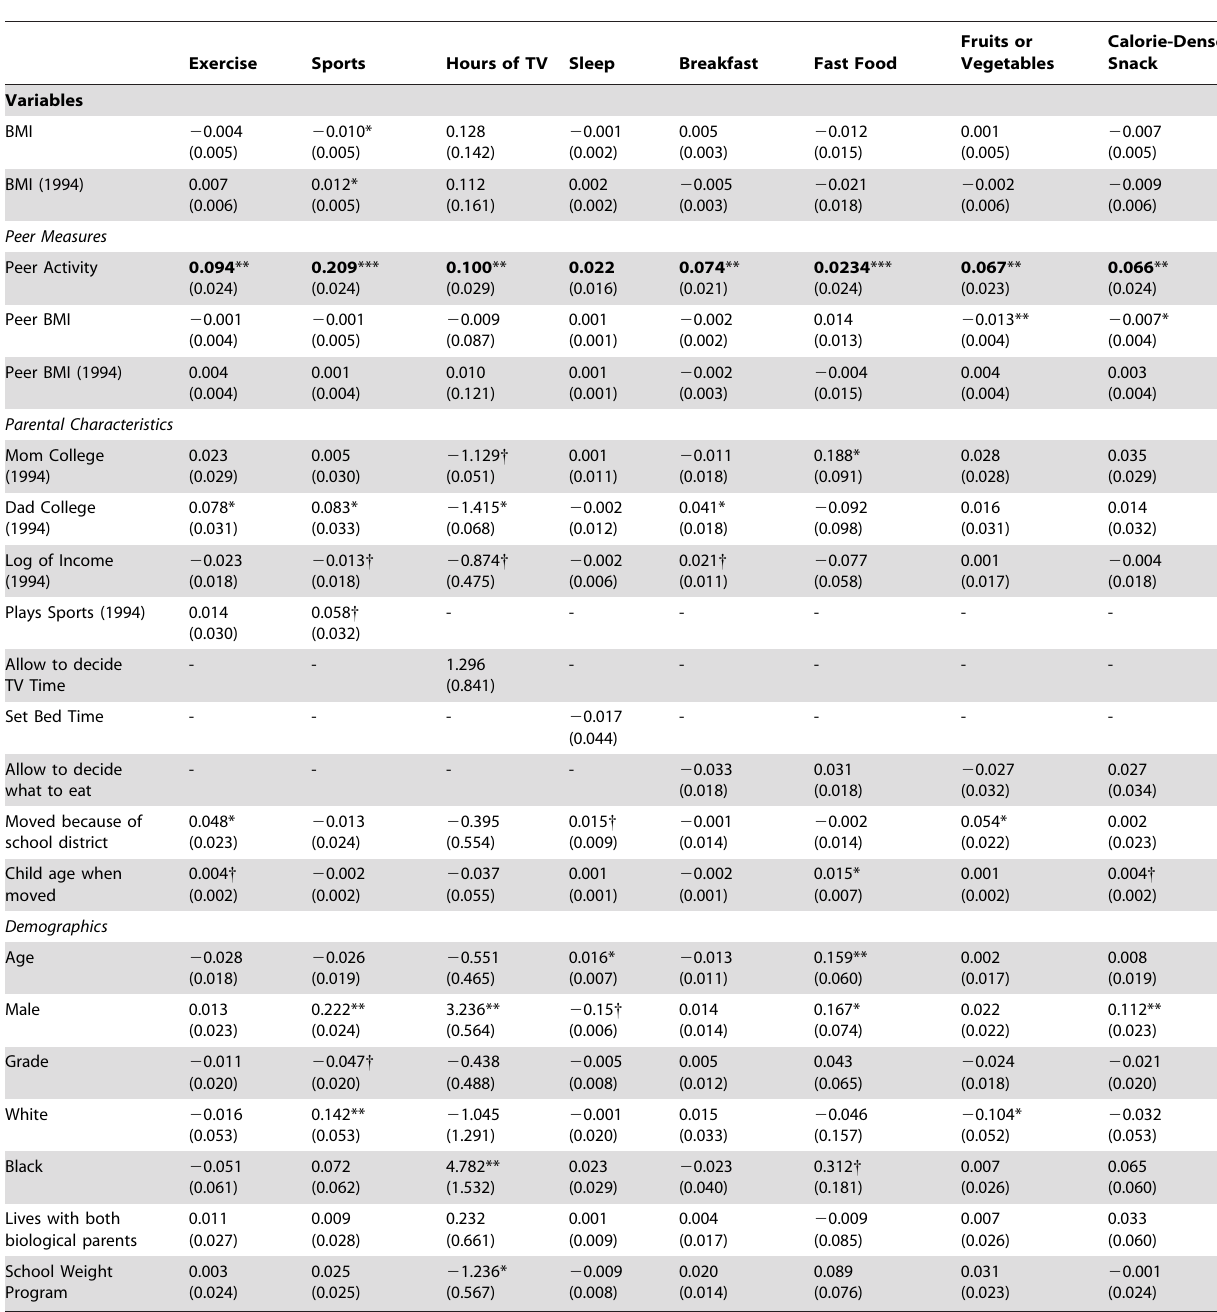
Table 5. Detailed Estimates from Full Specification (without school–level Fixed